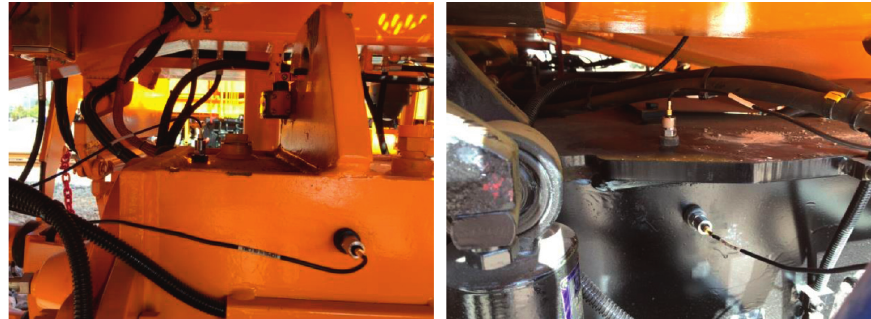
Figure 3: Sensor installation on the stabilizing device and bogie.